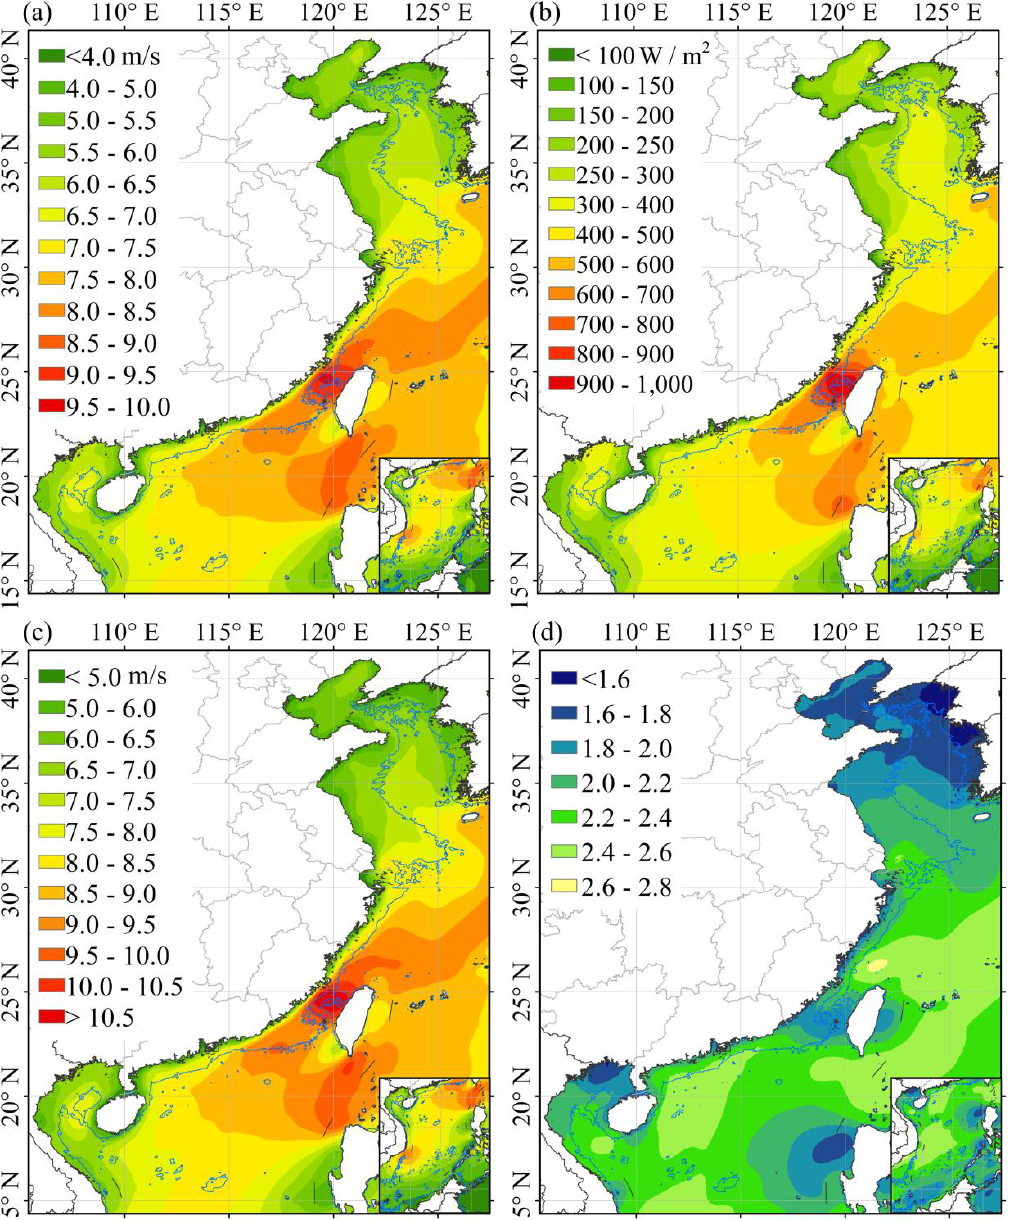
Figure 3. The geographic distribution of interpolated MWS, WPD, and Weibull parameters at 10 m above sea level using OCK method with a spatial resolution of 0.01 ◦ × 0.01 ◦ over the China Sea (the blue line indicates water depth at 50 m): ( a ) interpolated MWS, ( b ) interpolated WPD, ( c ) interpolated Weibull C, and ( d ) interpolated Weibull k.